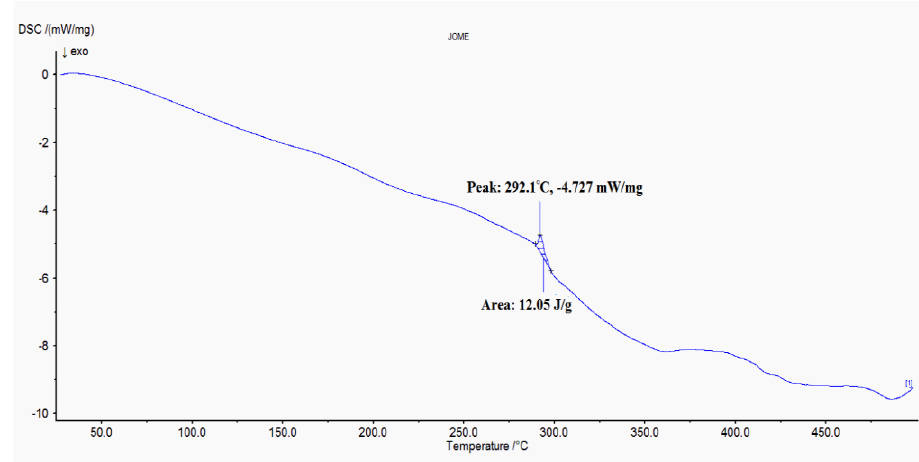
Figure 1. DSC combustion curve for JOME.